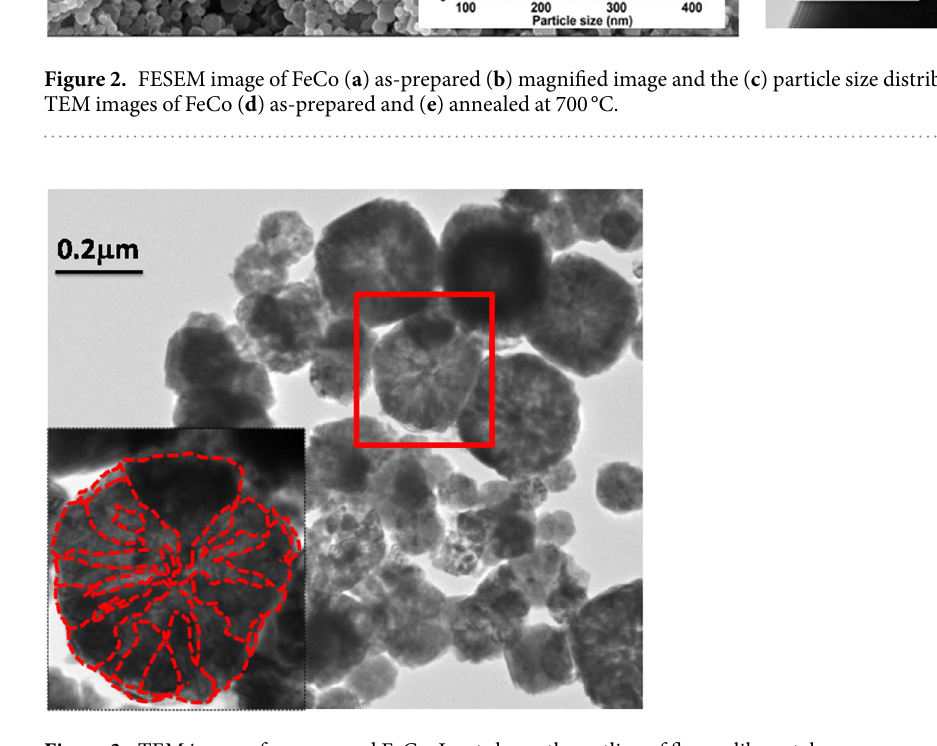
Figure 3. TEM image of as-prepared FeCo. Inset shows the outline of flower-like